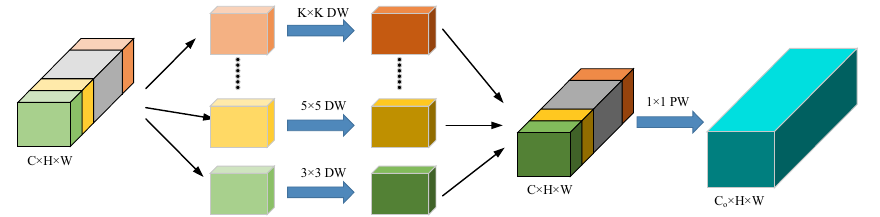
Figure 2. Mixed depthwise separable convolution.